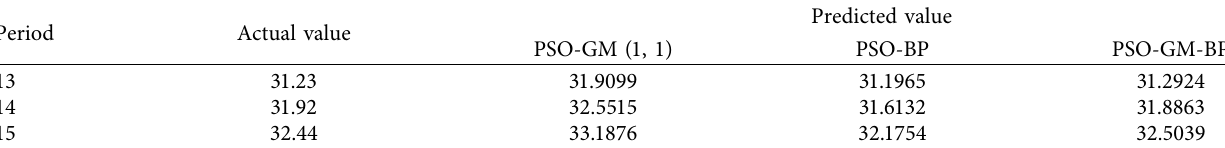
Table 14: Comparison of three models.